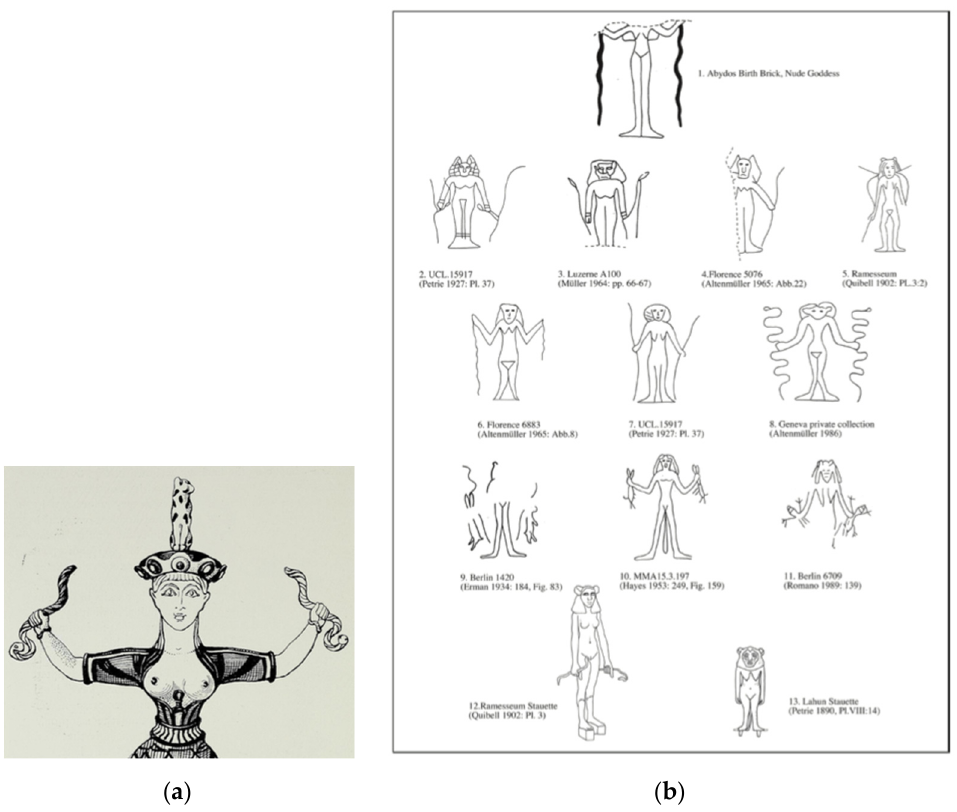
Figure 6. ( a ) Drawn detail of the reconstructed faience figurine from the Temple Repositories of Knossos (Evans 1921, p. 504, Fig. 362a); ( b ) Beset-type figures portrayed on the Abydos birth brick and apotropaic birth wands from Middle Kingdom Egypt, and Beset statuette from the Ramesseum (Wegner 2009, p. 466, Fig. 10). Courtesy of Josef Wegner.